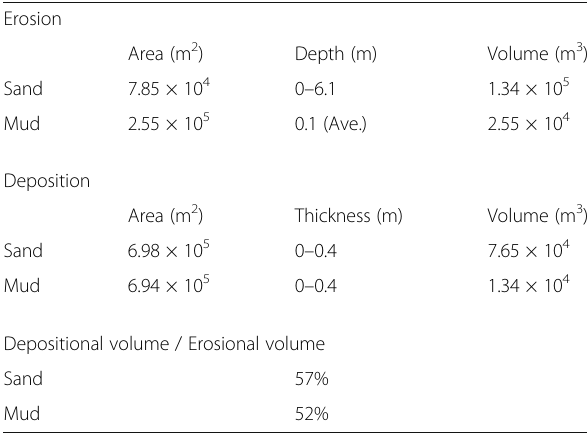
Table 3 Estimation of erosion and deposition by the tsunami in study area